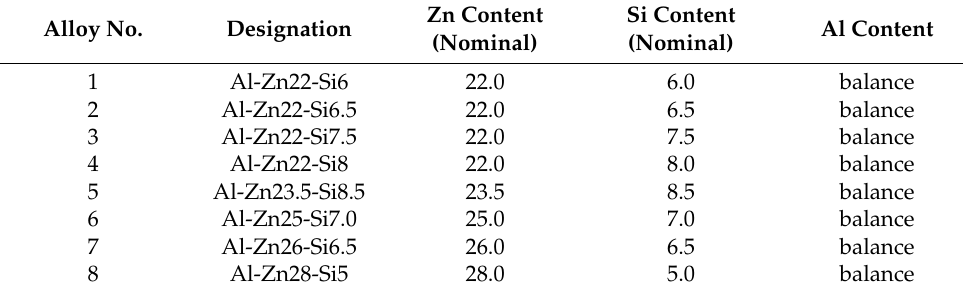
Table 1. Designation and nominal compositions of the low-melting aluminum alloys in